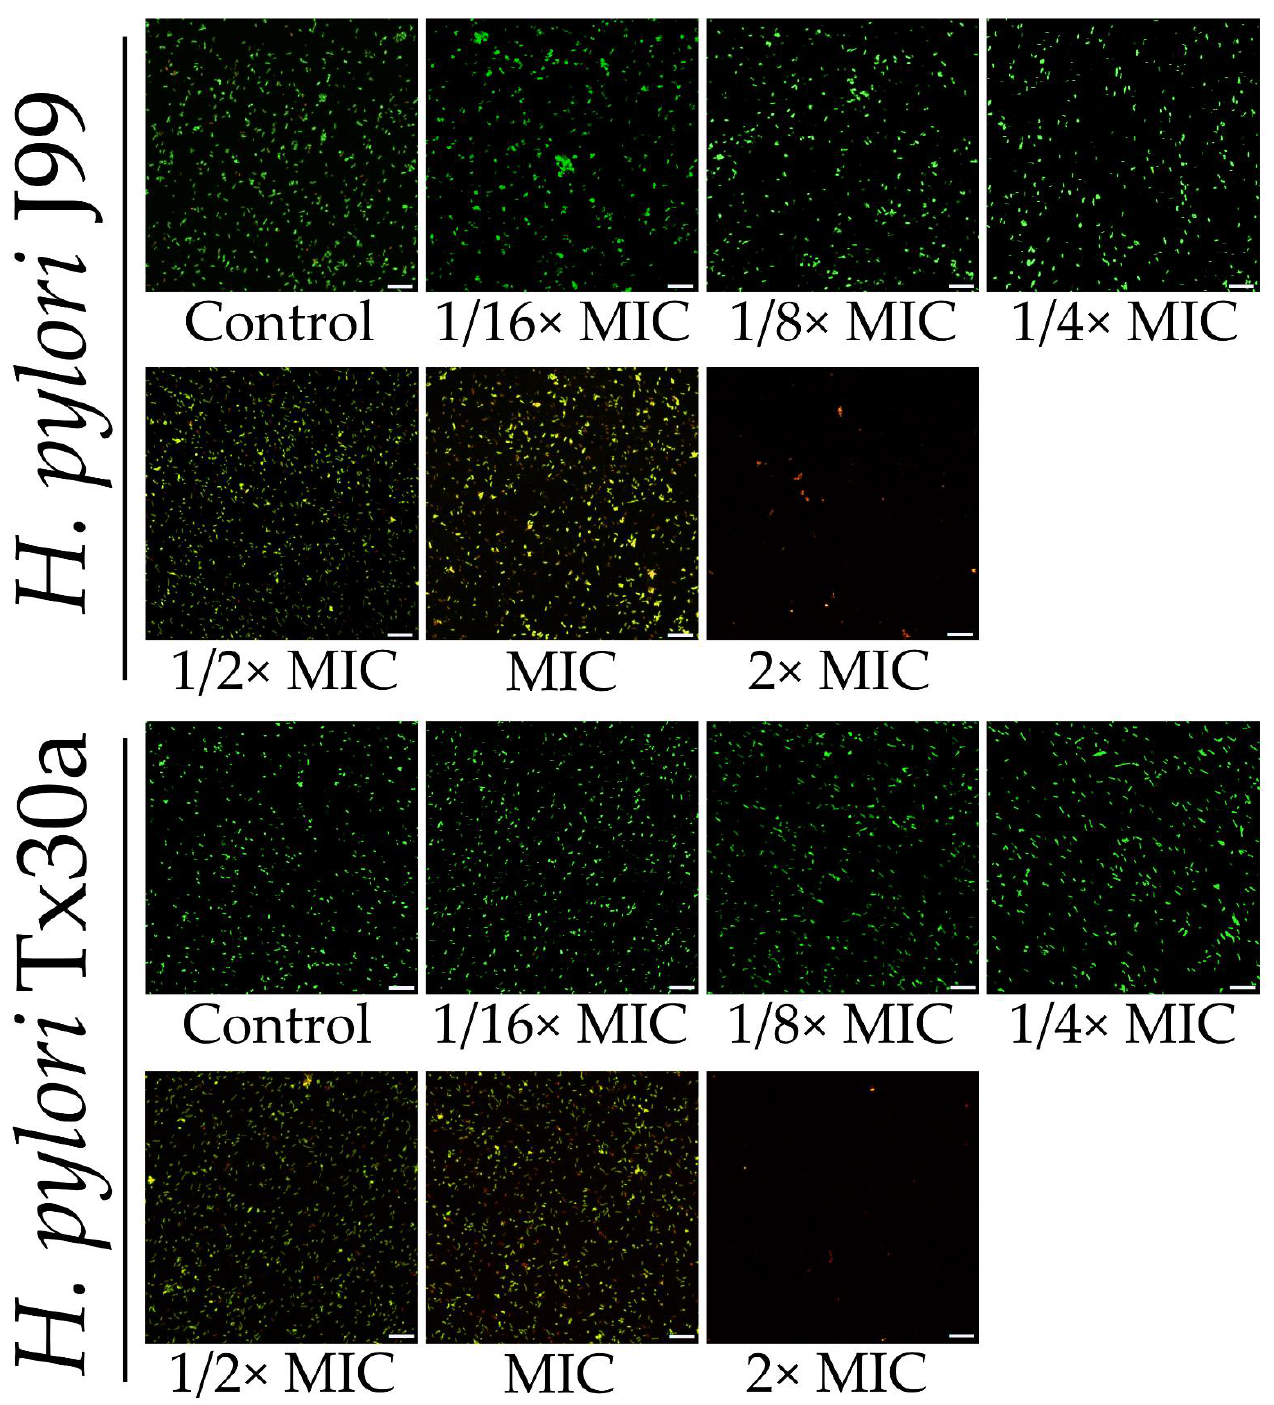
Figure 2. Representative fluorescence microscopy images of reference H. pylori J99 and Tx30a strains exposed to a gradient concentration of myricetin. The minimal inhibitory concentration (MIC) in both strains counts for 160 µg/mL, while minimal bactericidal concentration (MBC) is equal to 2× MIC and counts for 320 µg/mL. Bacterial cells were stained with a LIVE/DEAD kit. The scale bar shows 20 µm.